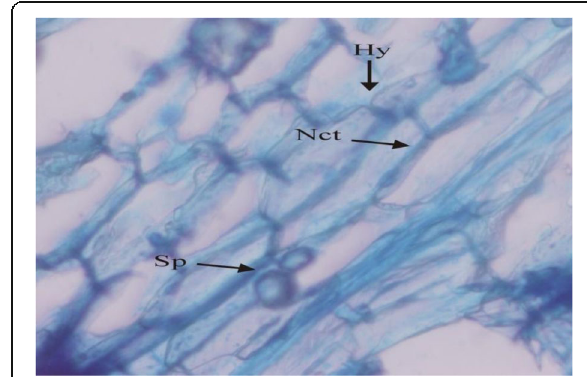
Fig. 8 Histopathological interaction of Trichoderma harzianum with roots tissue of tomato plants (longitudinal section, 40